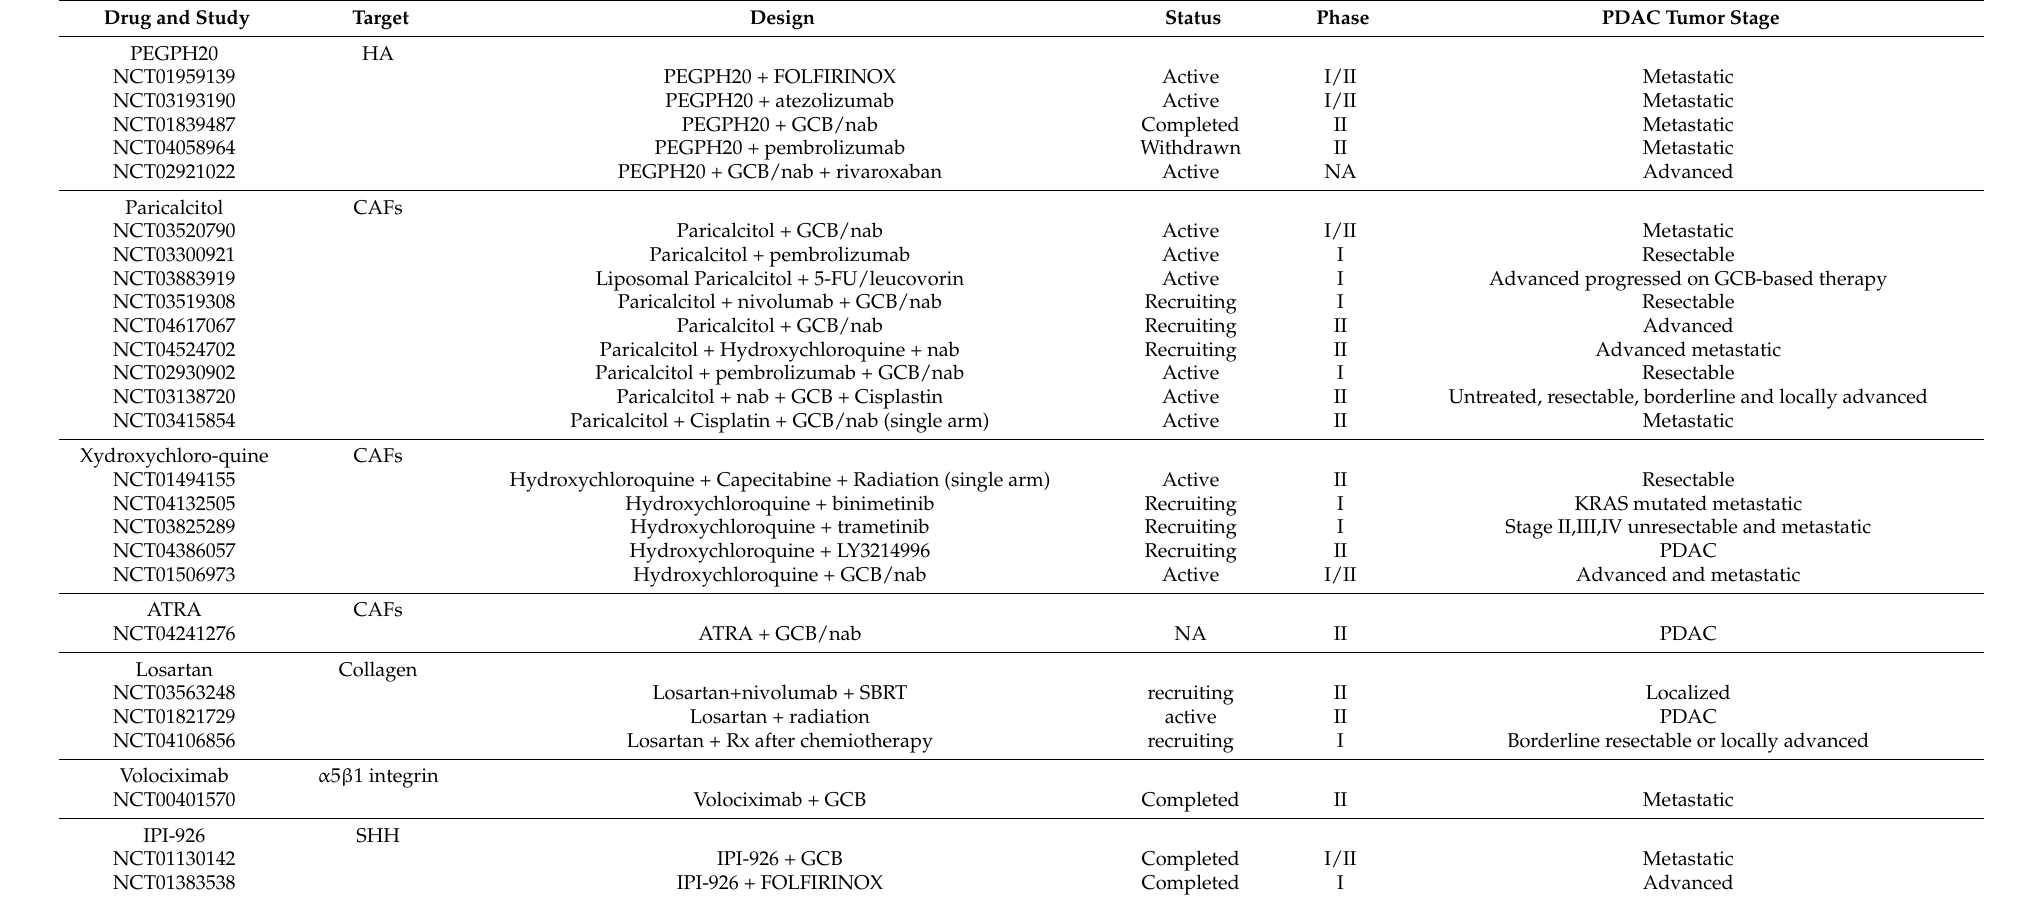
Table 1. List of completed, active or recruiting clinical trials for targeting the ECM in